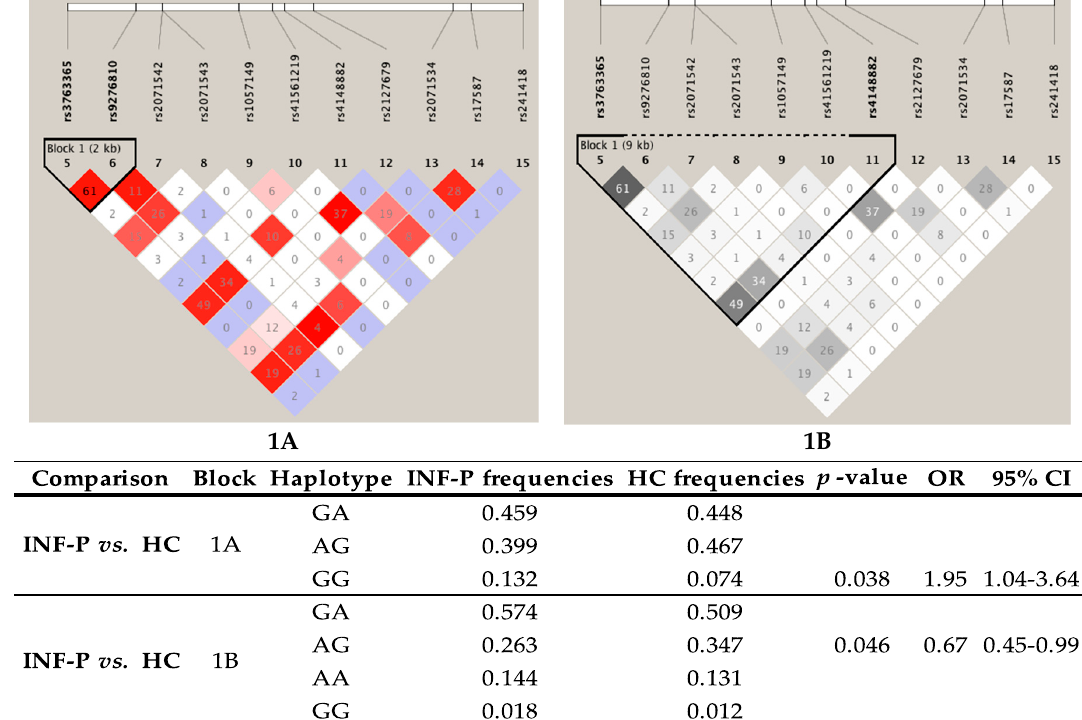
Figure 1. Haplotype analysis. ( A ) Haplotype conformed by the common allele of rs3763365 and rs9276810; ( B ) Haplotype conformed by minor alleles of rsr3763365 and rs41488882. INF-P—Patients with influenza A/H1N1 infection; HC—Healthy contacts. p -value < 0.05 was considered as significative.